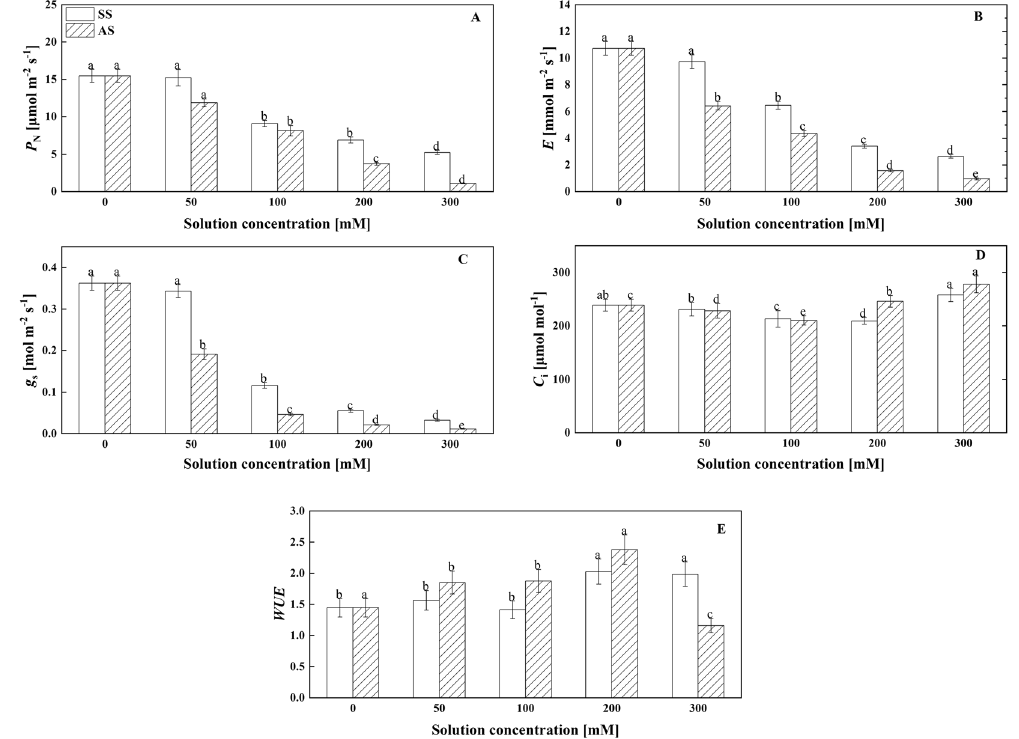
Figure 1. Effects of NaCl and NaHCO 3 concentrations on the ( A ) net photosynthetic rate (P N ), ( B ) transpiration rate (E), ( C ) stomatal conductance (g s ), ( D ) intercellular CO 2 concentration (C i ) and ( E ) water use efficiency (WUE) in the leaves of Goji berry. Values are represented as the mean ± SE (n = 5). Different letters indicate a significant difference at P < 0.05 by the least significant difference (LSD) test.